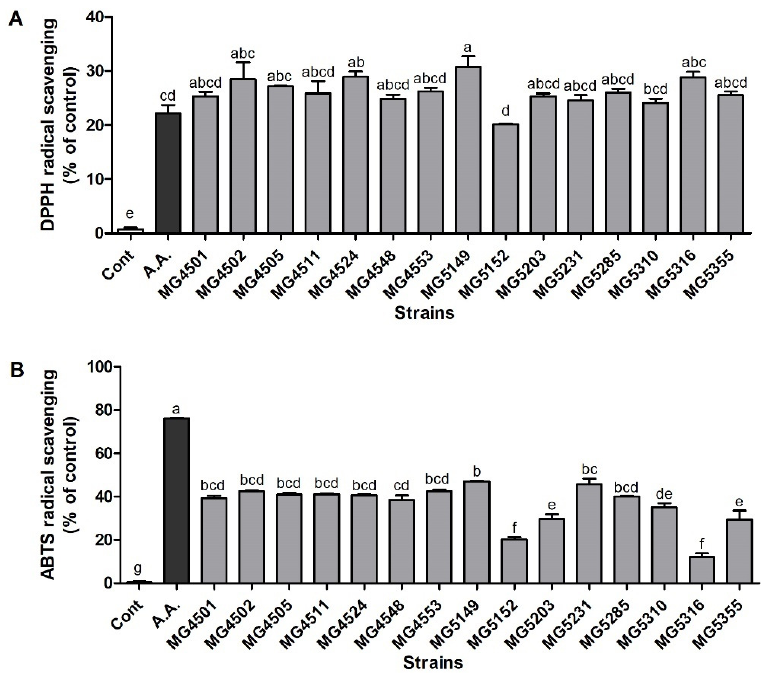
Figure 1. Antioxidant activities of the selected strains. ( A ) DPPH scavenging activity and ( B ) ABTS radical scavenging activity compared to control. The control was measured by adding PBS instead of LAB. All values are presented as the means ± SD from three independent experiments. Different letters indicate significant differences between means at p < 0.05 by Tukey’s multiple comparison tests. Cont; control. A.A.; ascorbic acid (10 µ g/mL).